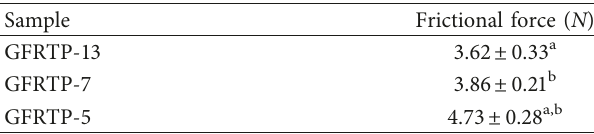
Table 3: Frictional forces of GFRTP wires against